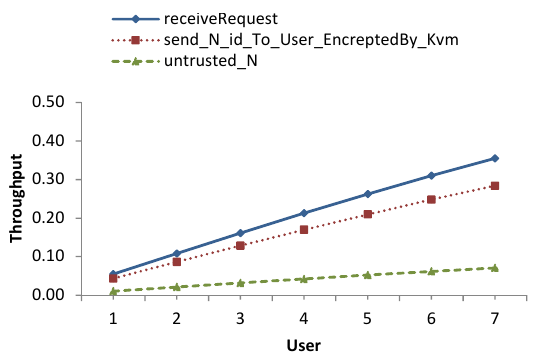
Figure 2: The throughput of the VM Launch Model, where the probability of trust ( p = 0 . 8) .